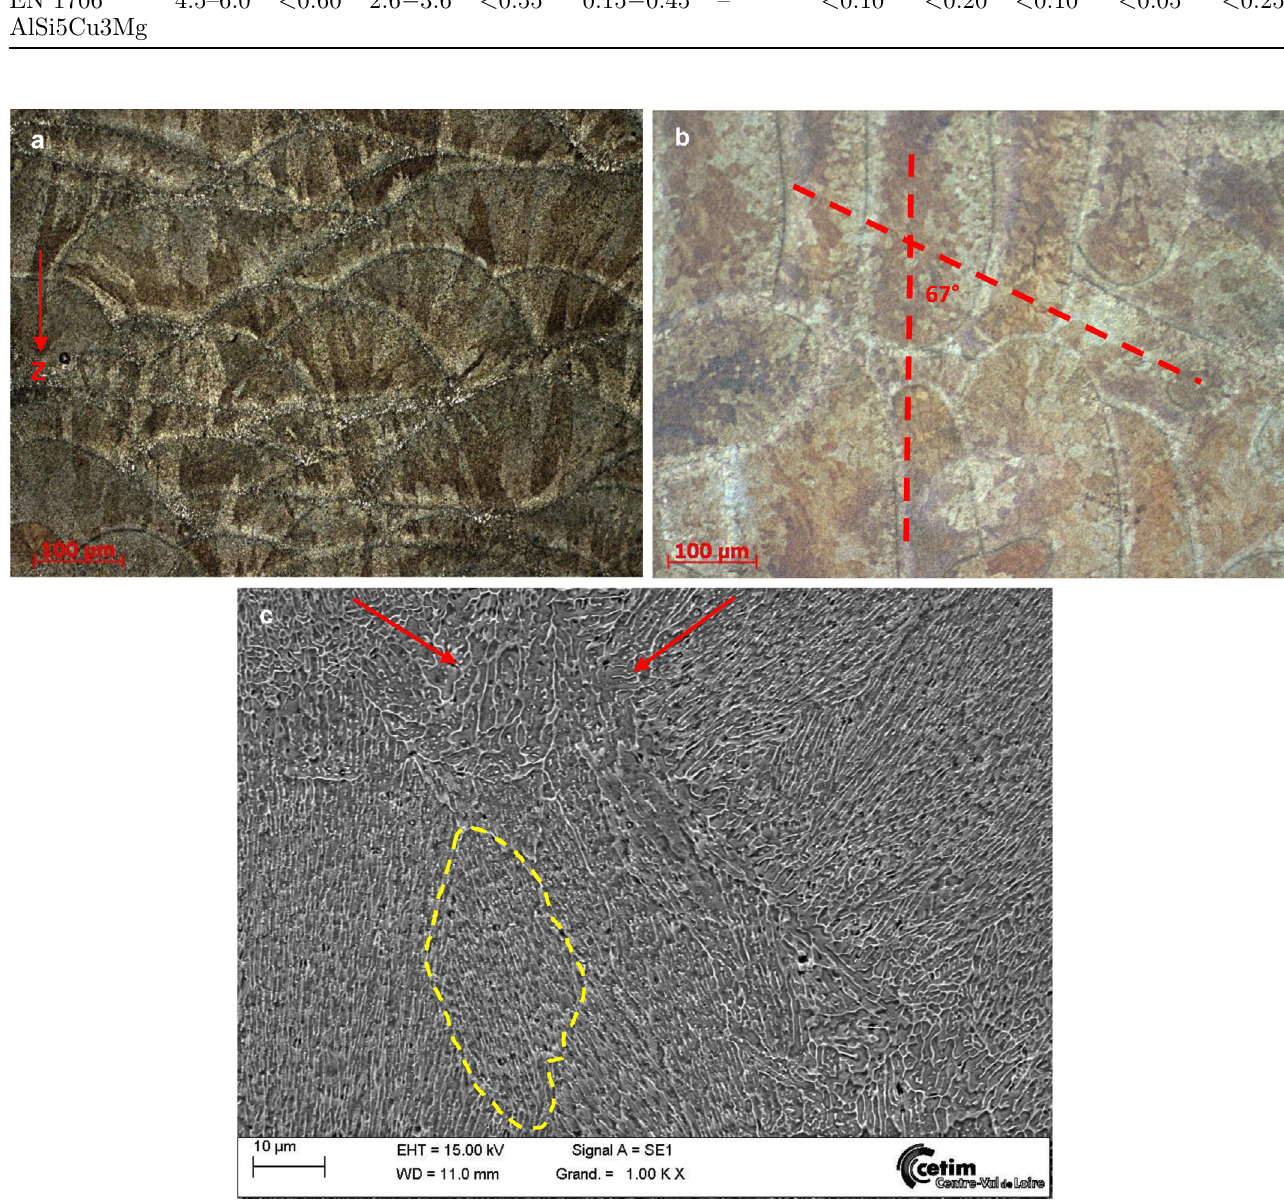
Fig. 2. As built temper (cid:1) (a) Micrographic examination Z direction (cid:1) (b) Micrographic examination XY plane (cid:1) (c) FEG-SEM examinations Z